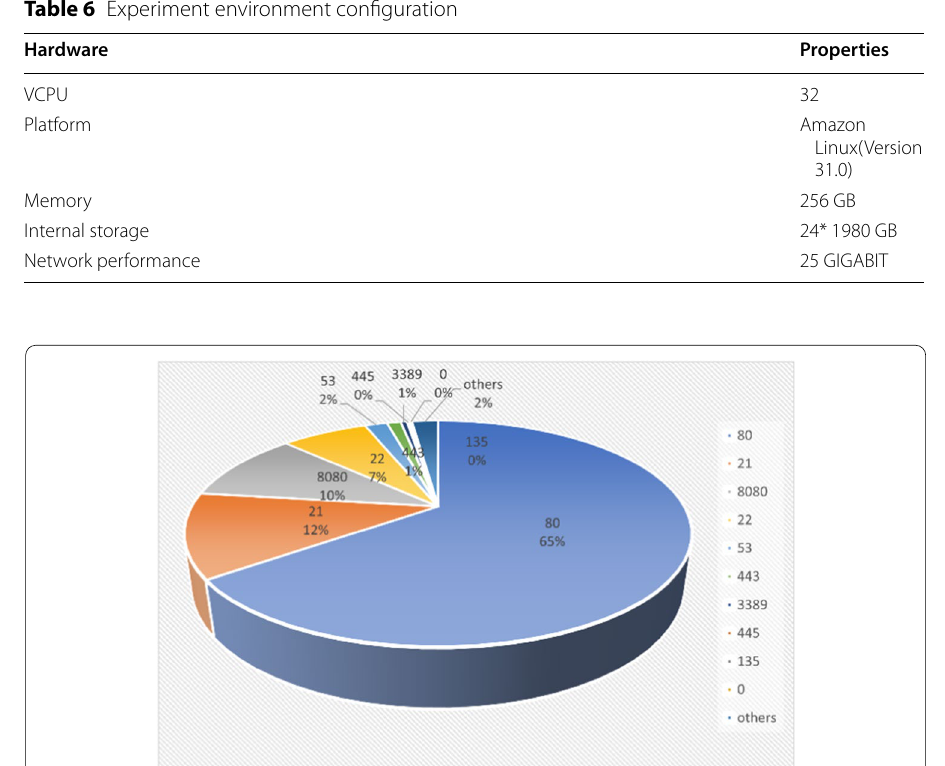
Table 6 Experiment environment configuration